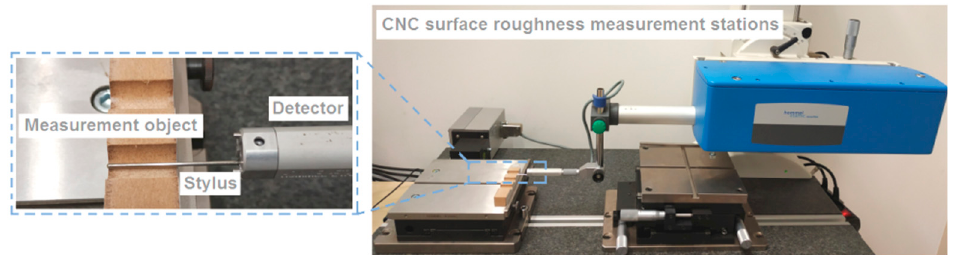
Figure 9. Measurement of surface topography.